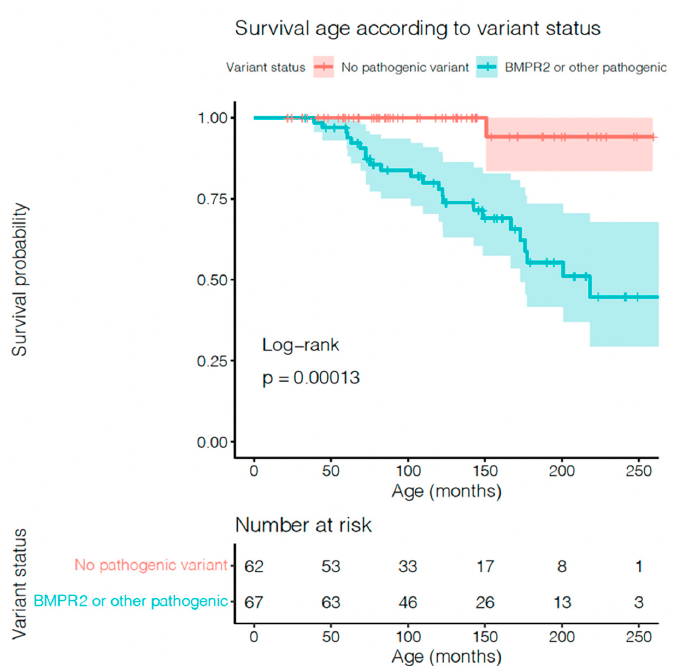
Figure 2. Relationship between genetic variant status and paediatric IPAH/HPAH mortality by